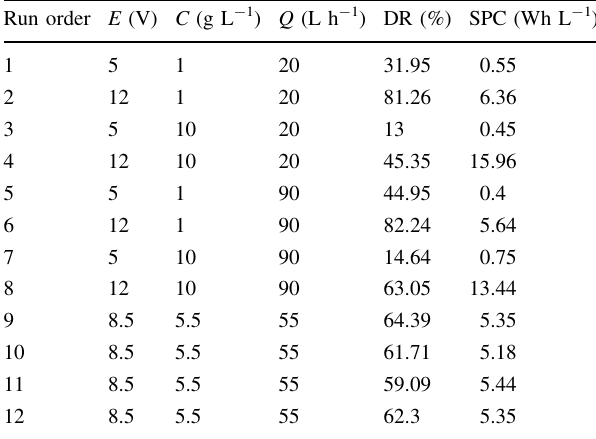
Table 4 Full factorial design matrix for desalination efficiency